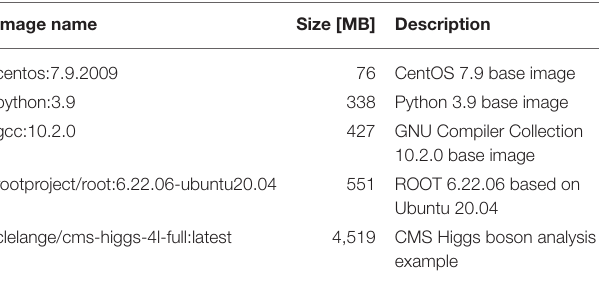
TABLE 1 | Container images used in the